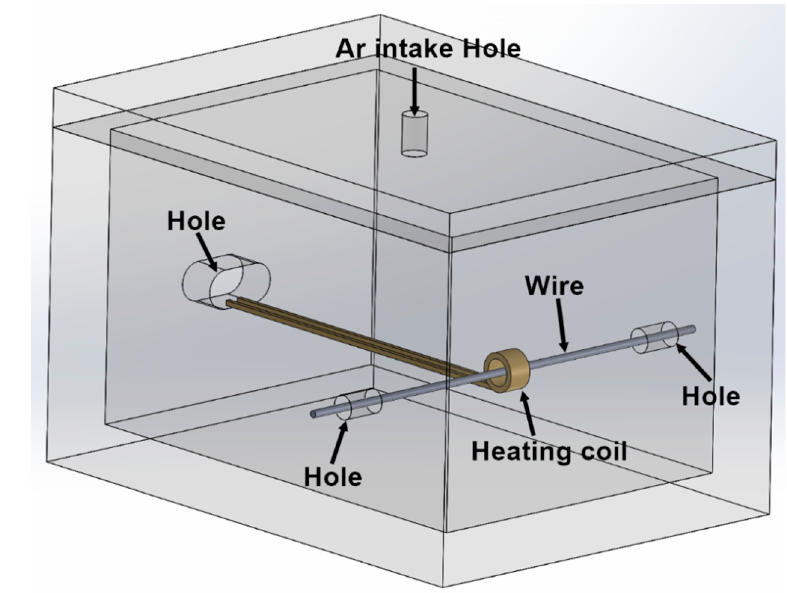
Figure 3. Schematic of self-designed argon gas chamber.